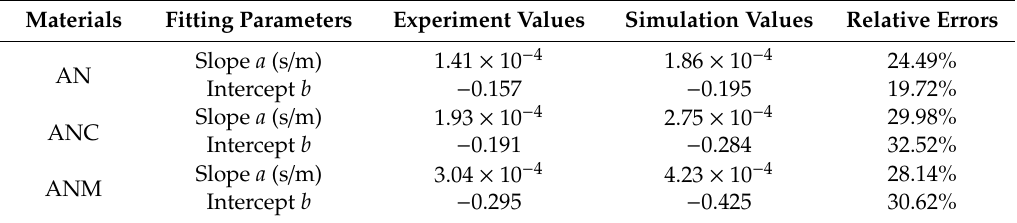
Figure 16. Comparison of the direct ballistic experiment results and the simulation fitting results: ( a ) AN; ( b ) ANC; ( c ) ANM. Table 12. Comparisons of the experimental results with the simulation results. Materials Fitting Parameters